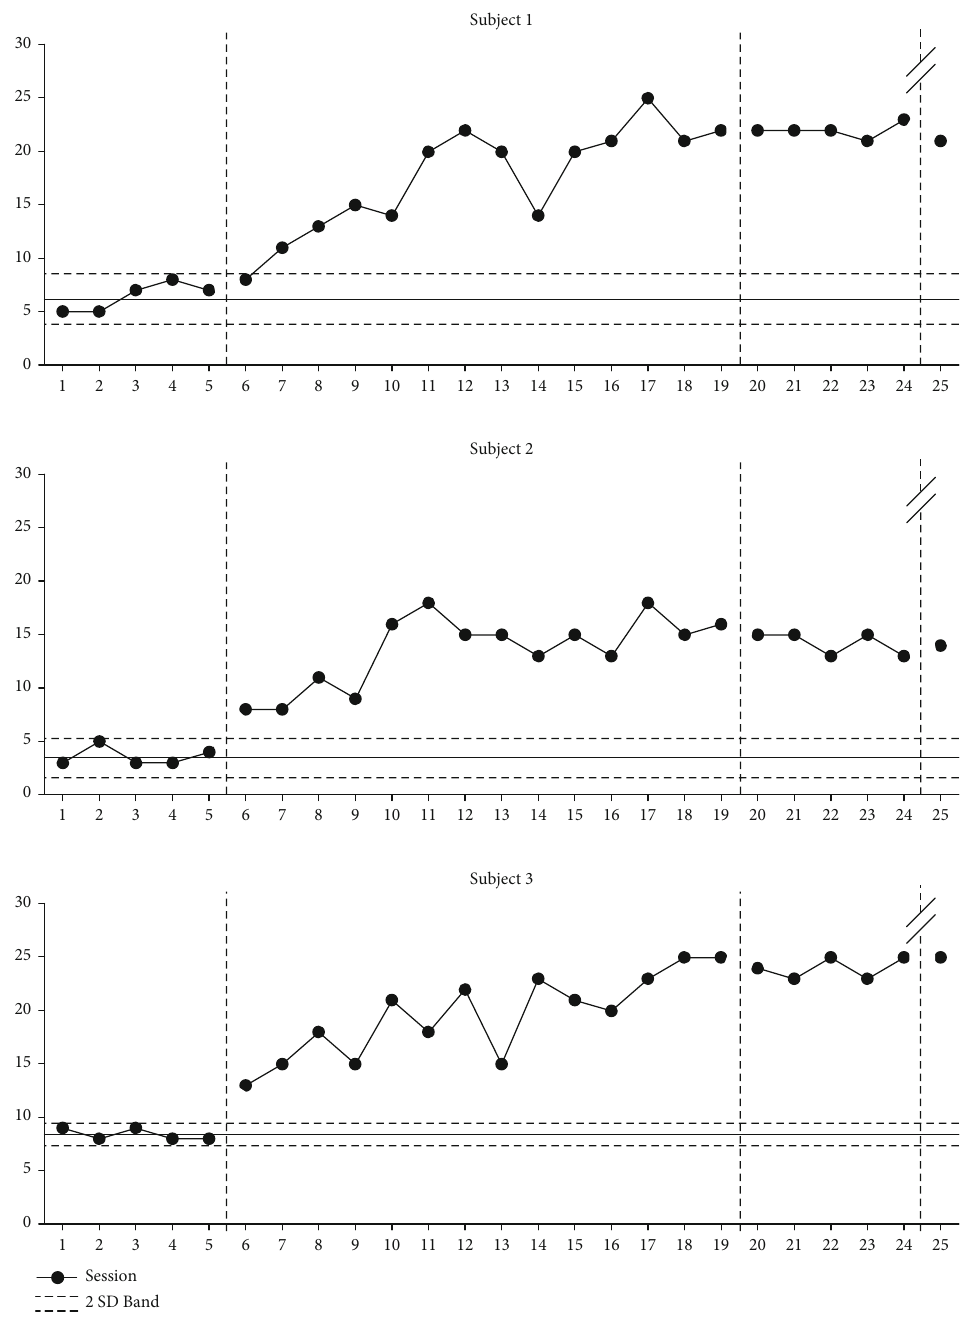
Figure 2: Changes in sequences